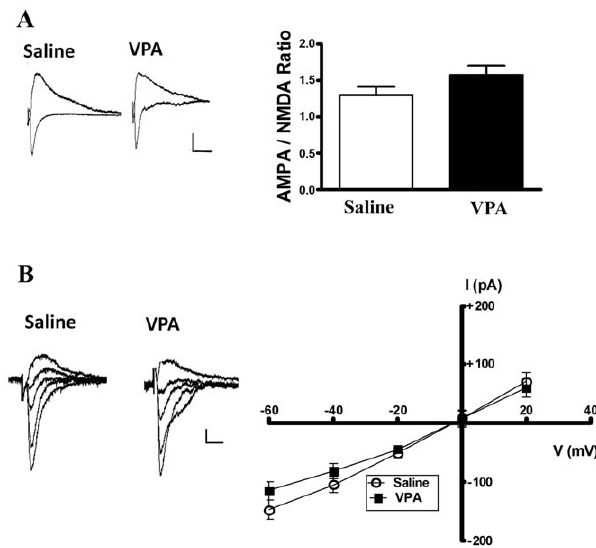
Figure 6. The AMPA/NMDA ratio in the LA neurons. (A) Sample traces showing the synaptic current at 2 70 and + 40 mV in the saline (n=9) and VPA (n=12) offspring. Average AMPA/NMDA ratio in the saline and VPA offspring at the thalamic–amygdala pathway. Scale; 50 ms, 40 pA. (B) No difference was observed in the current–voltage curve of AMPA receptor-mediated EPSCs in the LA neurons from the saline and VPA offspring. A sample trace and plot of the I–V curve of AMPA-mediated EPSCs were recorded in the presence of APV (20 m M) and bicuculline (10 m M) at holding potentials of 2 60 mV to + 20 mV in the saline (n=7) and VPA offspring (n=8) at the thalamic–amygdala pathway. Scale; 50 ms, 40 pA.